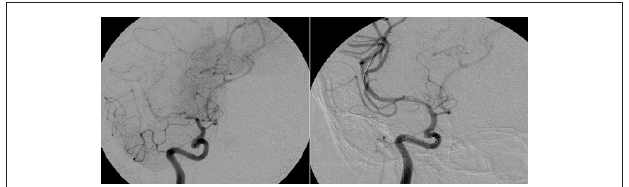
FiGuRe 1 | Right middle cerebral artery stenosis treated with SeiS/ Wingspan